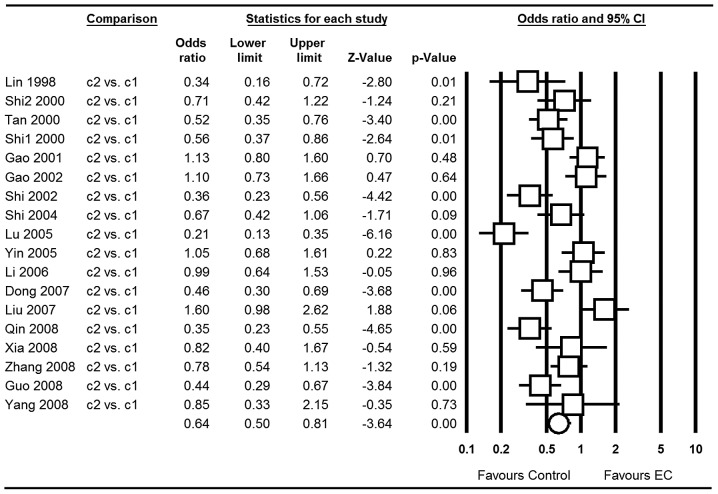
Forest plot of EC associated with CYP2E1 RsaI/PstI for the c2 allele compared with the c1 allele in total. CI, confidence interval; EC, esophageal cancer.